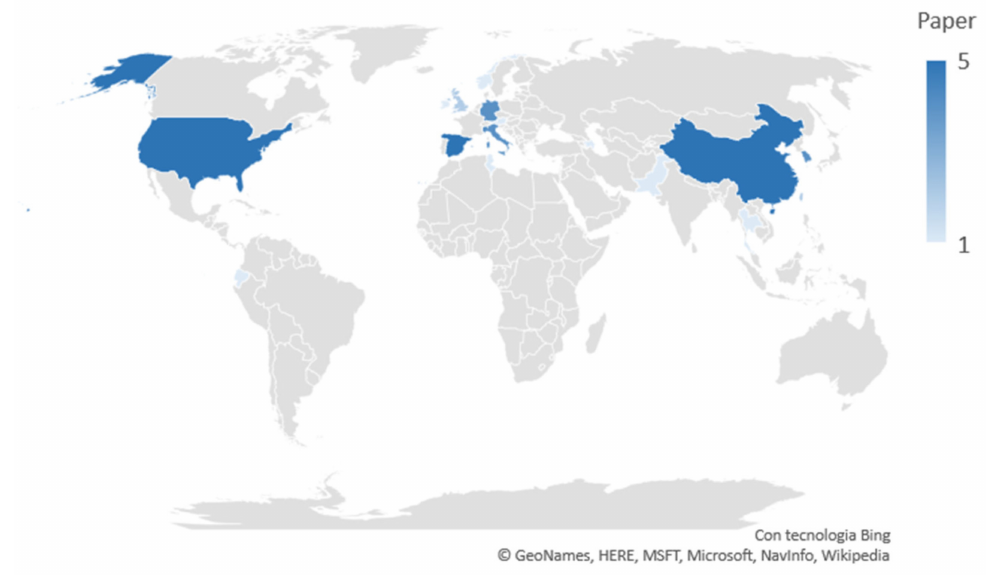
Figure 7. Country distribution (source: Scopus).